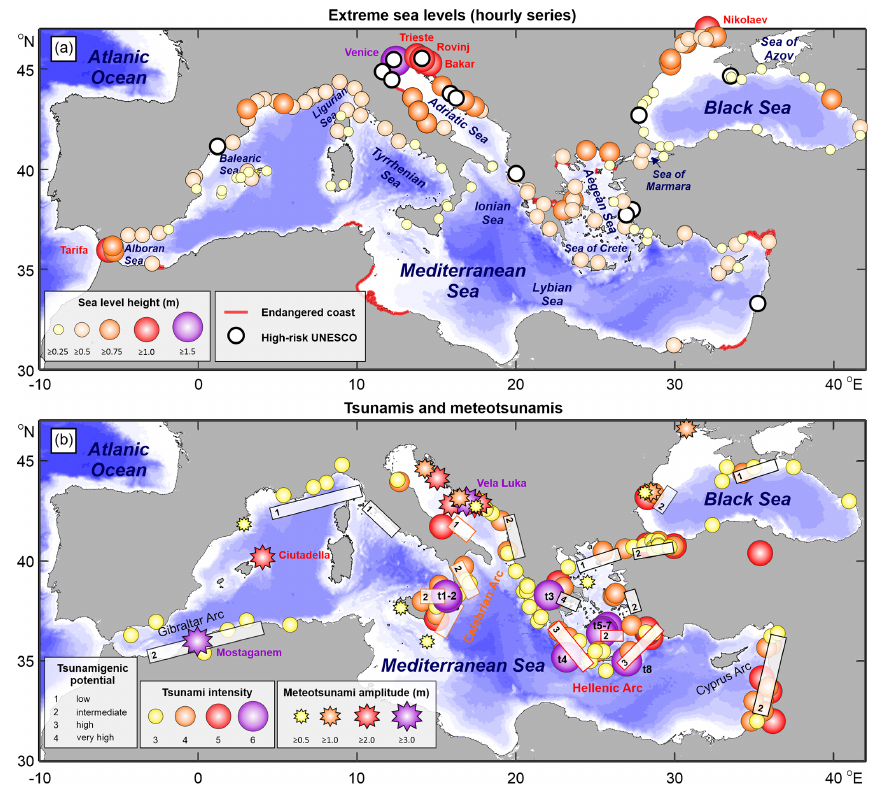
Figure 1. (a) Maximum measured sea level heights (with respect to a local mean), based on the GESLA Version 3 dataset and available national databases, are given (coloured circles); strips of coast (red lines) and UNESCO heritage sites (white circles) endangered by present and future-day sea level rise and erosion (after Reimann et al., 2018). (b) Epicentres of earthquakes which resulted in historic tsunamis having intensities of 3 or higher (coloured circles, after Maramai et al., 2014); tsunamigenic fault areas are depicted by white rectangles, and tsunamigenic potential is indicated by the numbers 1–4 (after Fokaefs and Papadopoulos, 2007, and Oaie et al., 2016); locations of historic meteotsunamis surpassing an amplitude of 0.5m are marked with coloured stars (after Vilibi´c et al., 2010, 2016; Orli´c, 2015; Šepi´c et al., 2018; Okal, 2021). For extreme hourly sea levels and meteotsunamis, locations at which the most extreme events occurred are named; for tsunamis, the epicentres of earthquakes leading to the eight most destructive tsunamis are marked with